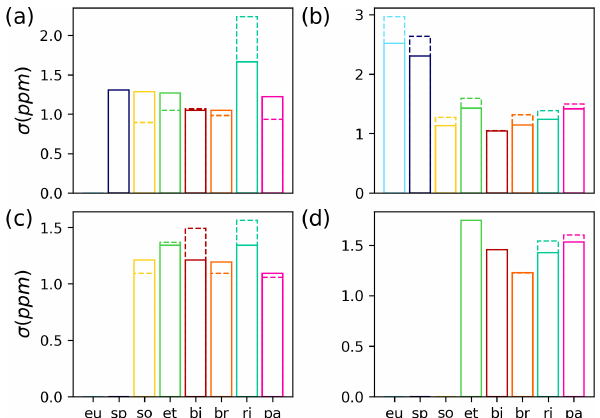
Figure 6. Same as Fig. 5 but shows the precision at each site for each season. (a) Spring (March, April, May); (b) summer (June, July, August); (c) fall (September, October, November); (d) winter (December, January, February). Solid bars indicate the NN filter, and dashed bars indicate the original B10 qc_filter.